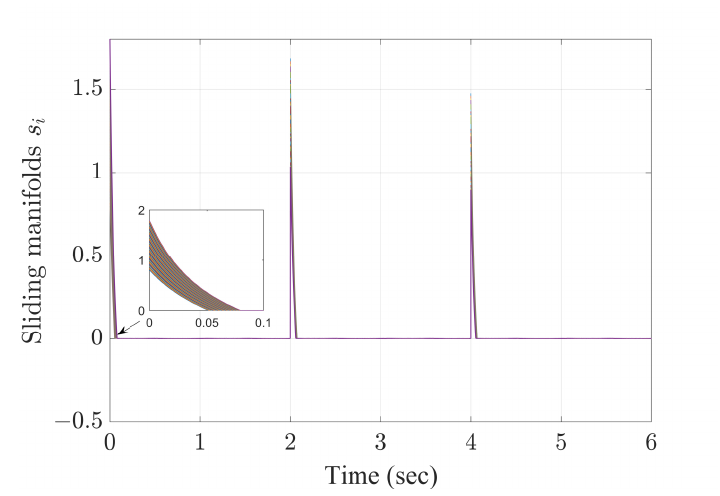
Figure 5. Convergence trajectories of sliding